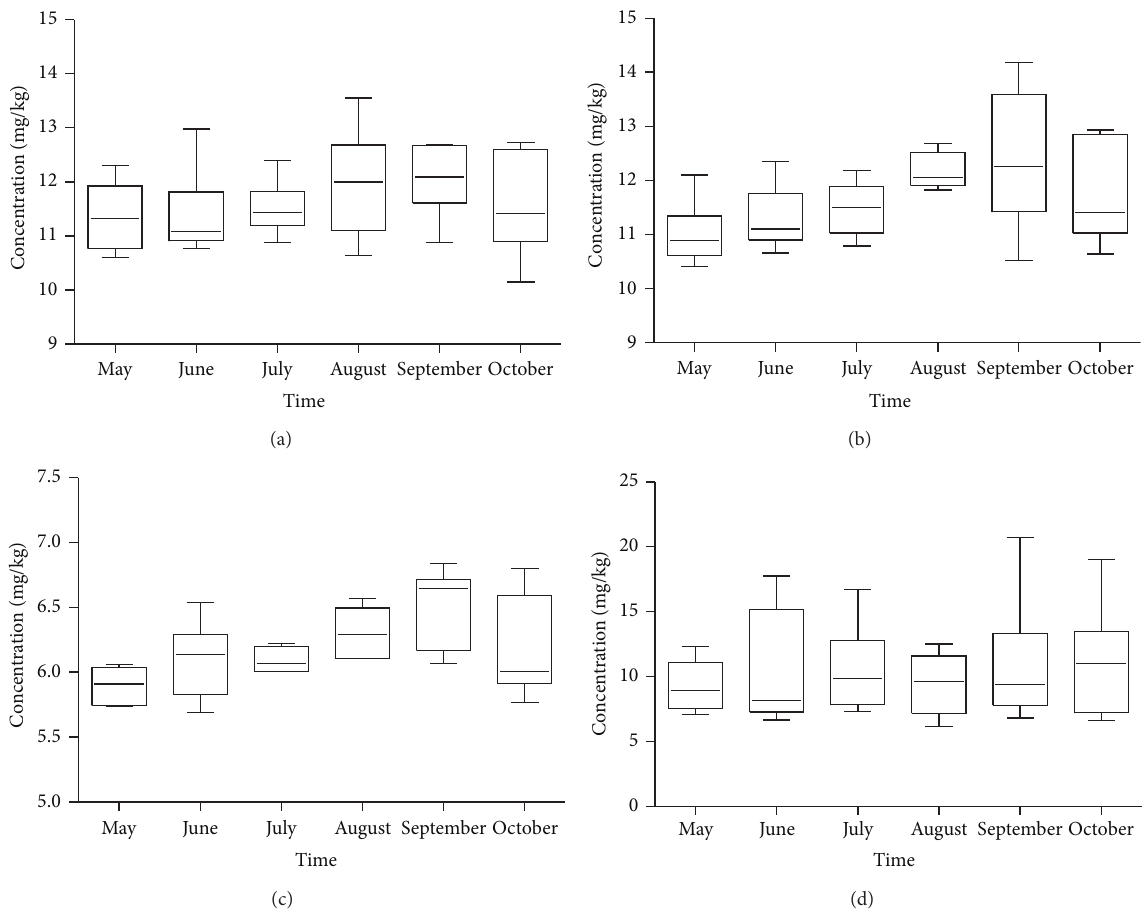
Figure 2: Temporal variations of the soil heavy metal concentrations at site 1. (a) Changes in the Cr concentration; (b) changes in the Pb concentration; (c) changes in the Ni concentration; and (d) changes in the Zn